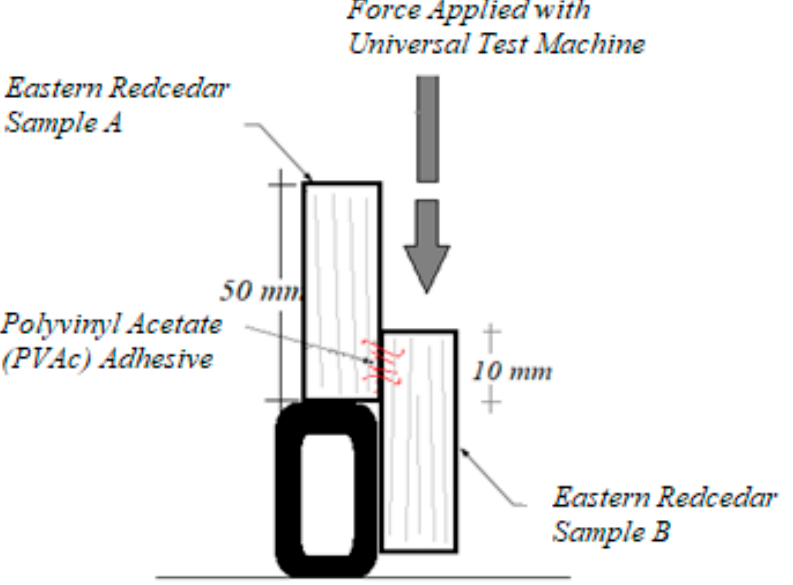
Figure 6. Adhesive bondline shear strength measurement with Comten 95 Series Universal Testing machine.